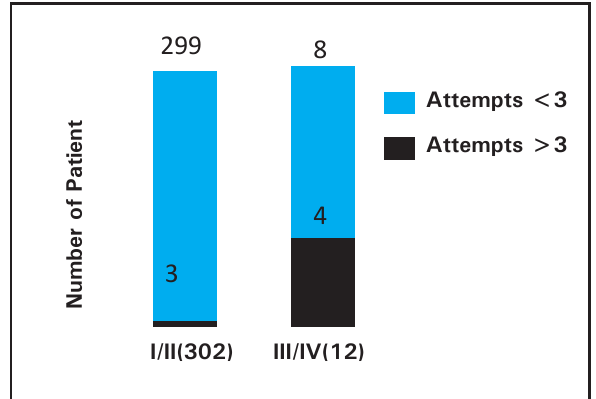
Figure 2. Comparison between laryngoscopic view and attempts at